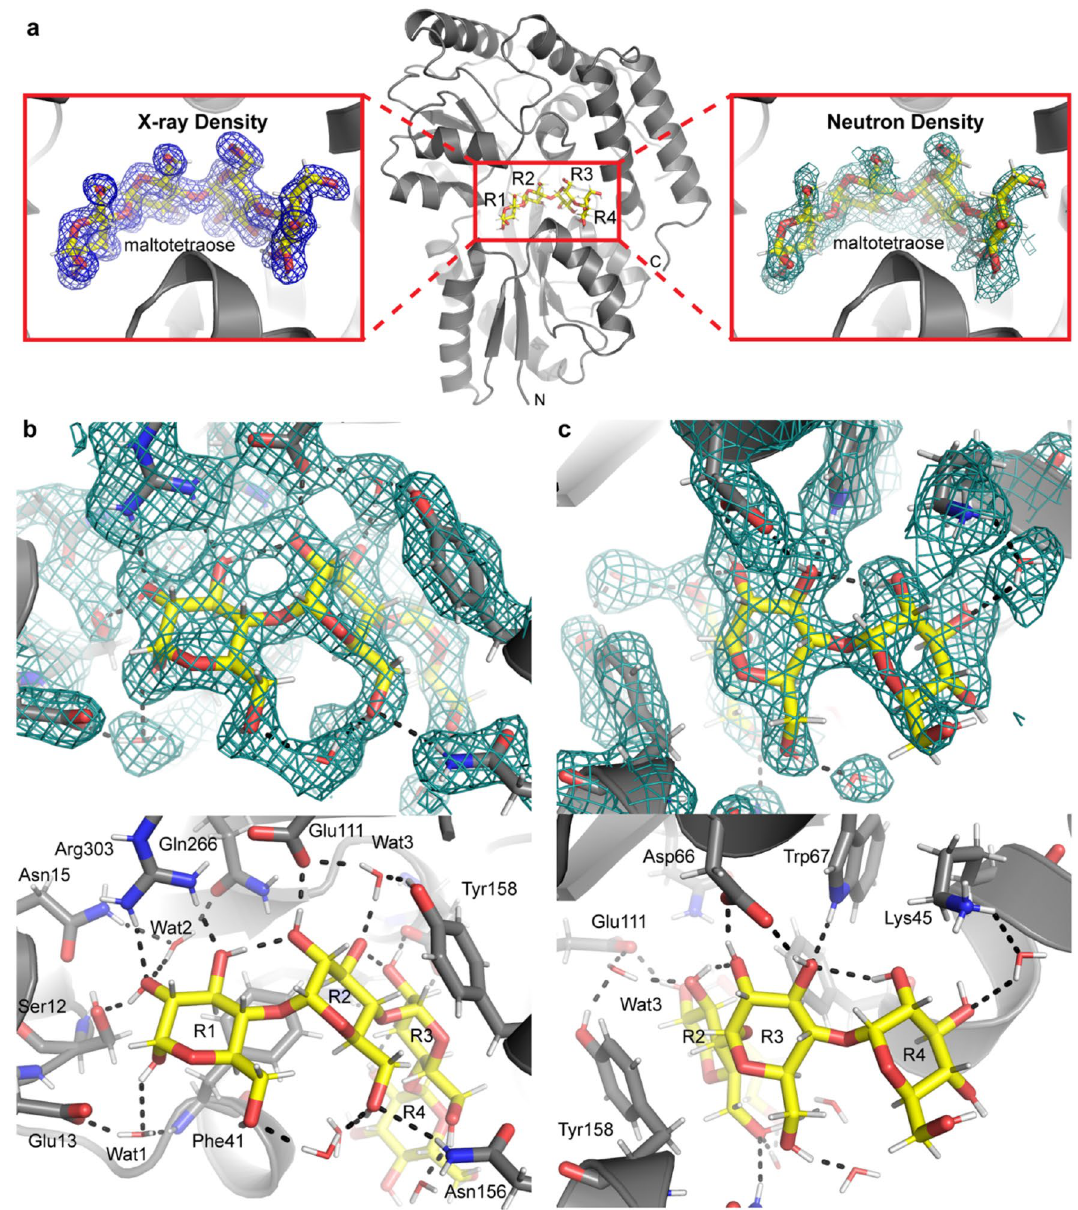
Figure 1. The neutron crystal structure of tmMBP. ( a ) Center, overall structure of tmMBP bound to maltotetraose (stick representation with yellow carbon atoms). The N- and C-termini are indicated as well as the nomenclature for the maltotetraose rings (R1–R4). Left, 2Fo–Fc electron density for maltotetraose contoured at 1.4 sigma. Right, 2Fo–Fc nuclear density for maltotetraose contoured at 1.1 sigma. ( b ) Top, close-up view of the 2Fo–Fc nuclear density for the R1/R2 subsite contoured at 1.0 sigma. Bottom, close-up view of the R1/R2 hydrogen bonding network identified from the nuclear density maps. Hydrogen bonds are represented as black dashed lines. ( c ) Top, close-up view of the 2Fo–Fc nuclear density for the R3/R4 subsite 1.0 sigma. Bottom, close-up view of the R3/R4 hydrogen bonding network identified from the nuclear density maps. Hydrogen bonds are represented as black dashed